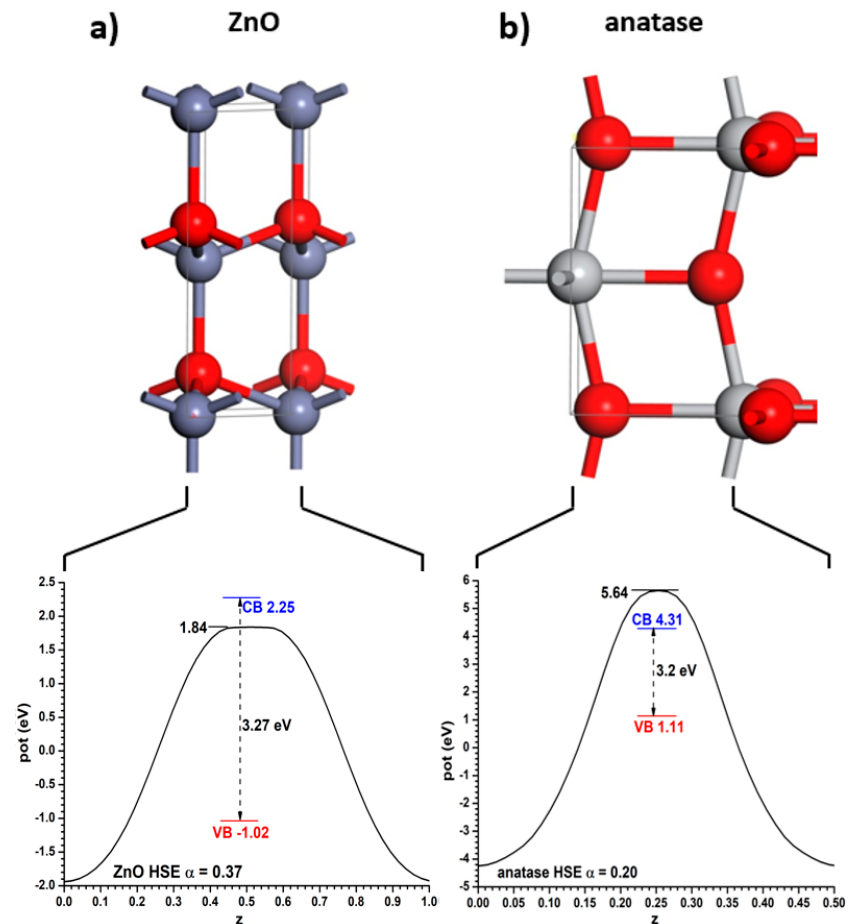
Figure 1. ( a ) Structure of fully relaxed ZnO, with (110) plane vertical and perpendicular to the drawing plane, displaying below it the curve of the plane-averaged Hartree potential together with the positions of the VB and CB. ( b ) the same for the anatase TiO 2 structure, with the (001) plane located in the same way. The band positions were obtained using the HSE06 functional with the indicated α values of Fock exchange fraction. z coordinate means, here and always, the ratio between atomic positions and cell dimension.